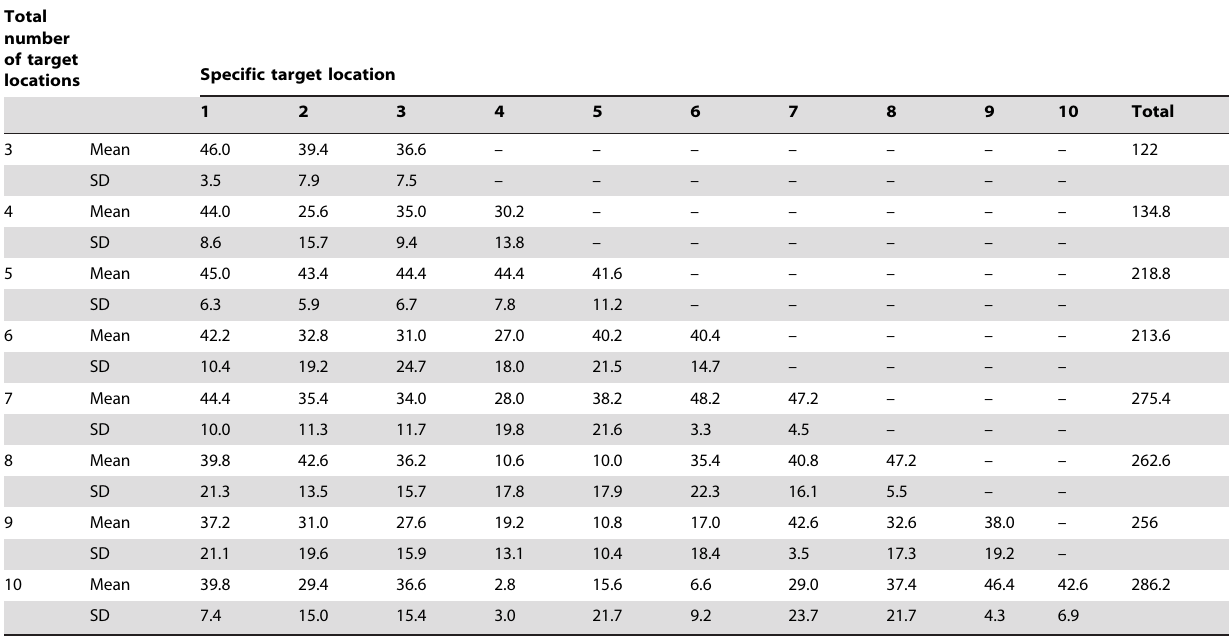
Table 4. Distribution of responses as the number of spatial locations is increased.